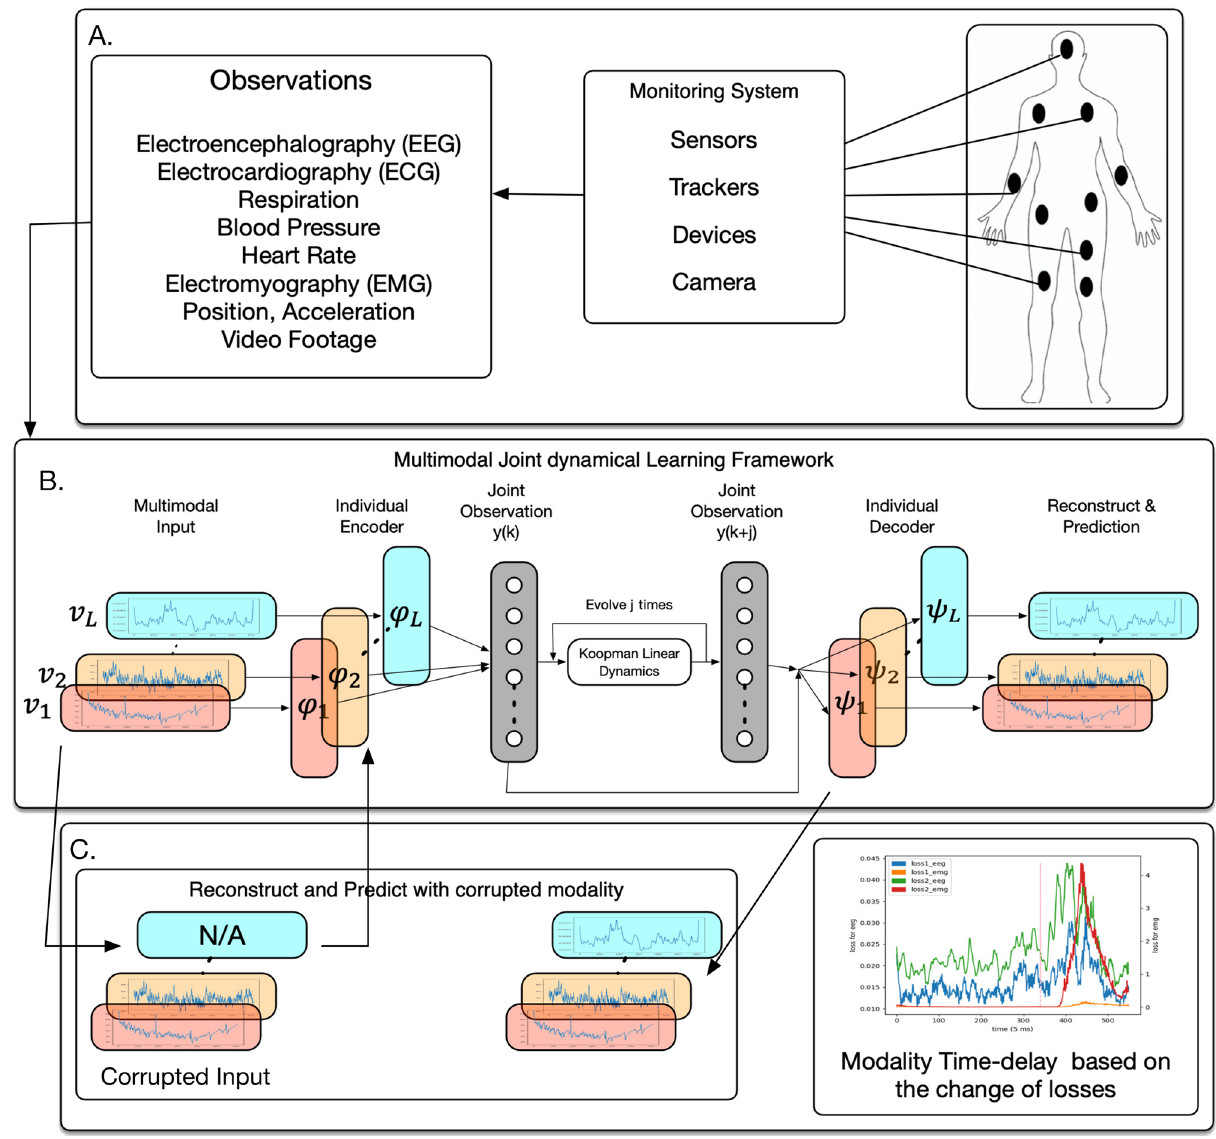
Figure 1. An illustration of the proposed Koopman-operator based multi-modal deep auto-encoder network for the joint intrinsic dynamics of a dynamical